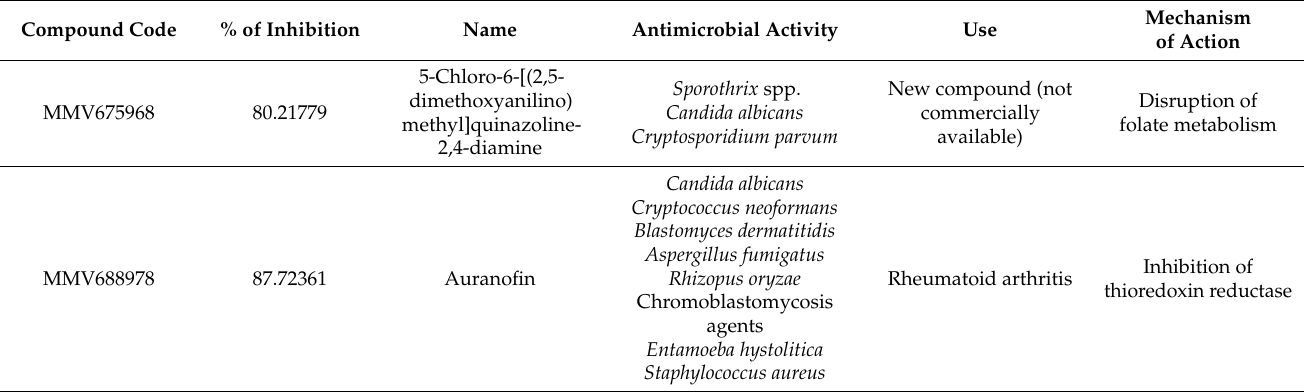
Table 1. Identification of the selected compounds from the screening of the Pathogen Box library. Compound